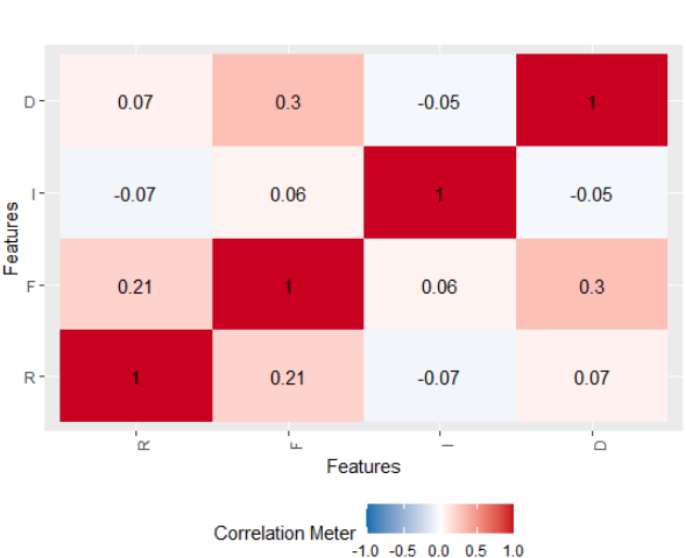
Figure 7. Correlation Matrix of ∆ − 1 ( R ) , ∆ − 1 ( F ) , ∆ − 1 ( I ) , and ∆ − 1 ( F )